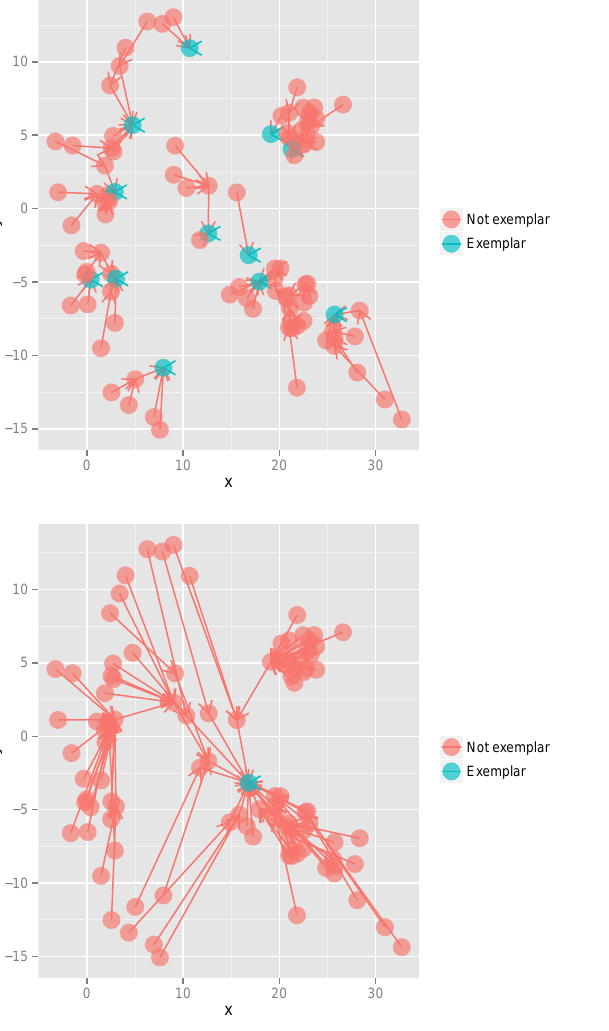
Figure 3. Networks obtained with scale factor k = 5 , k = 10 , k = 20 , and k = 40 with dataset of Figure 1 (A). The exemplars are displayed with blue filled